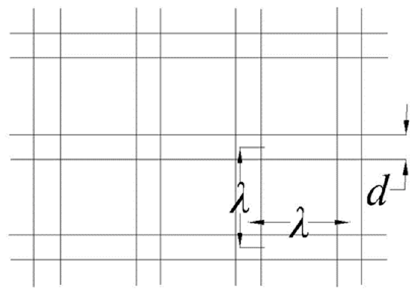
Figure 1. Equivalent netting